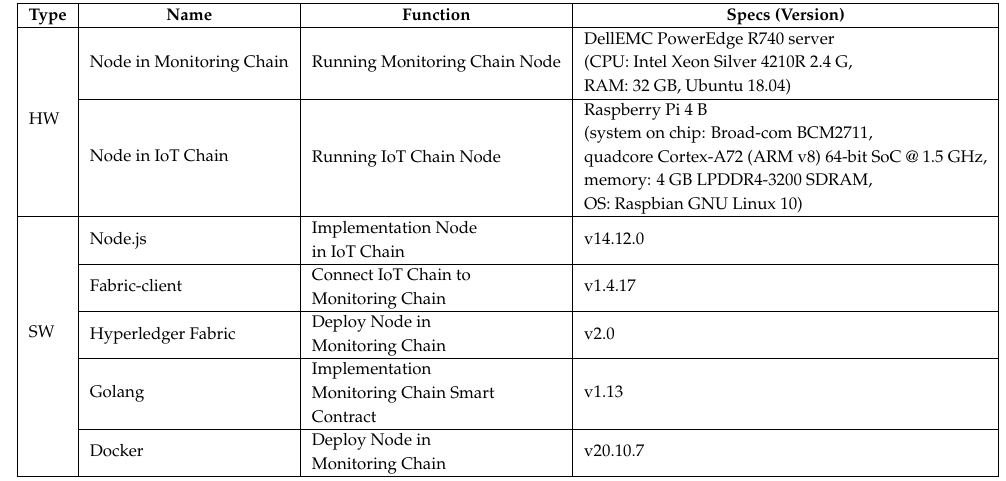
Table 5. Experimental